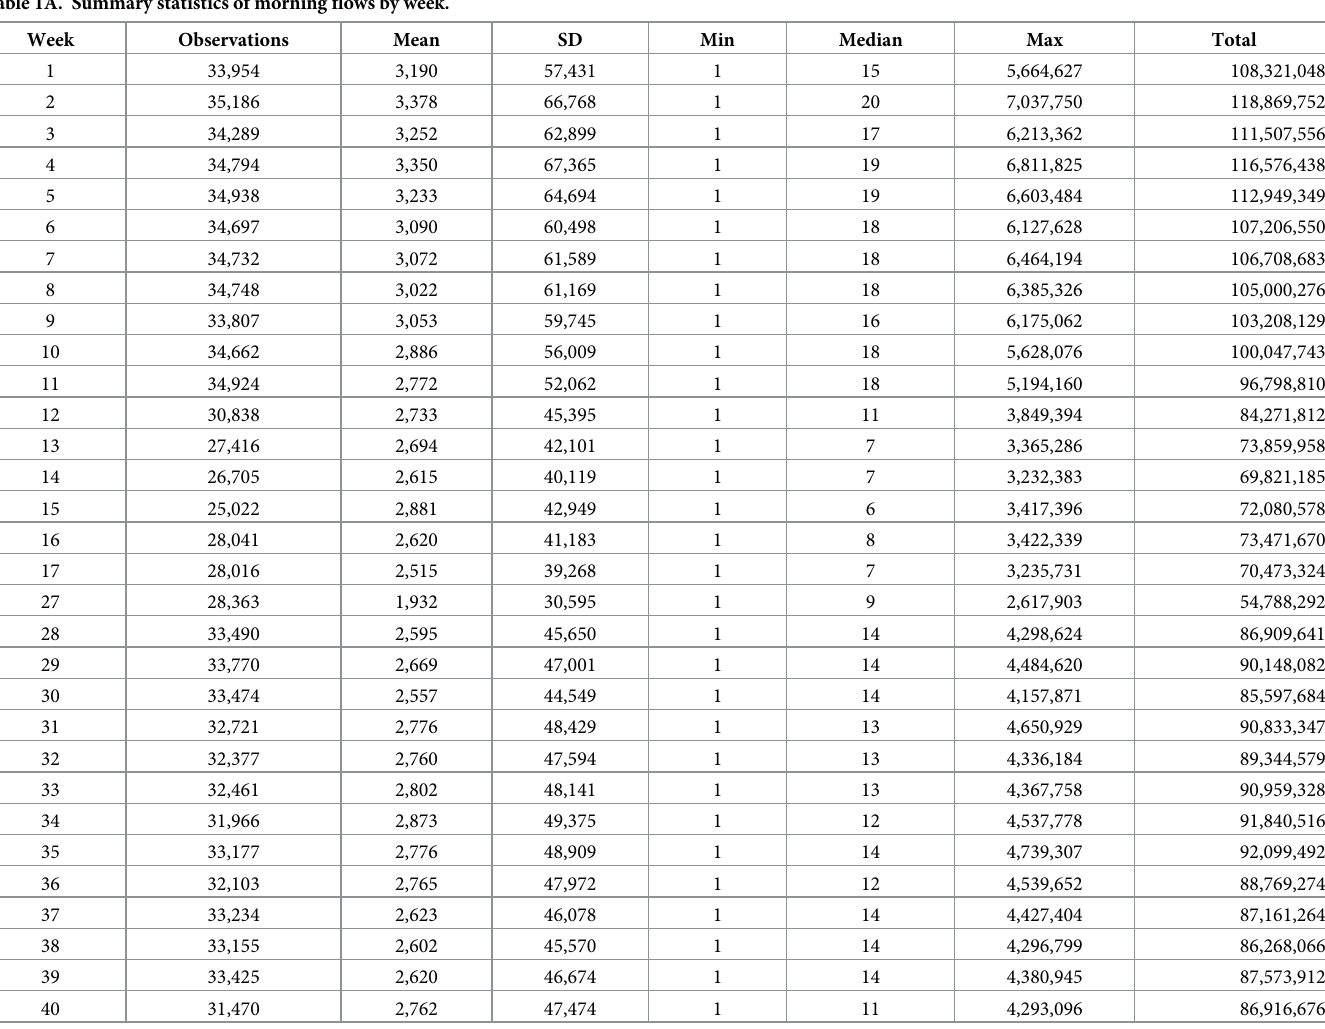
Table 1A. Summary statistics of morning flows by